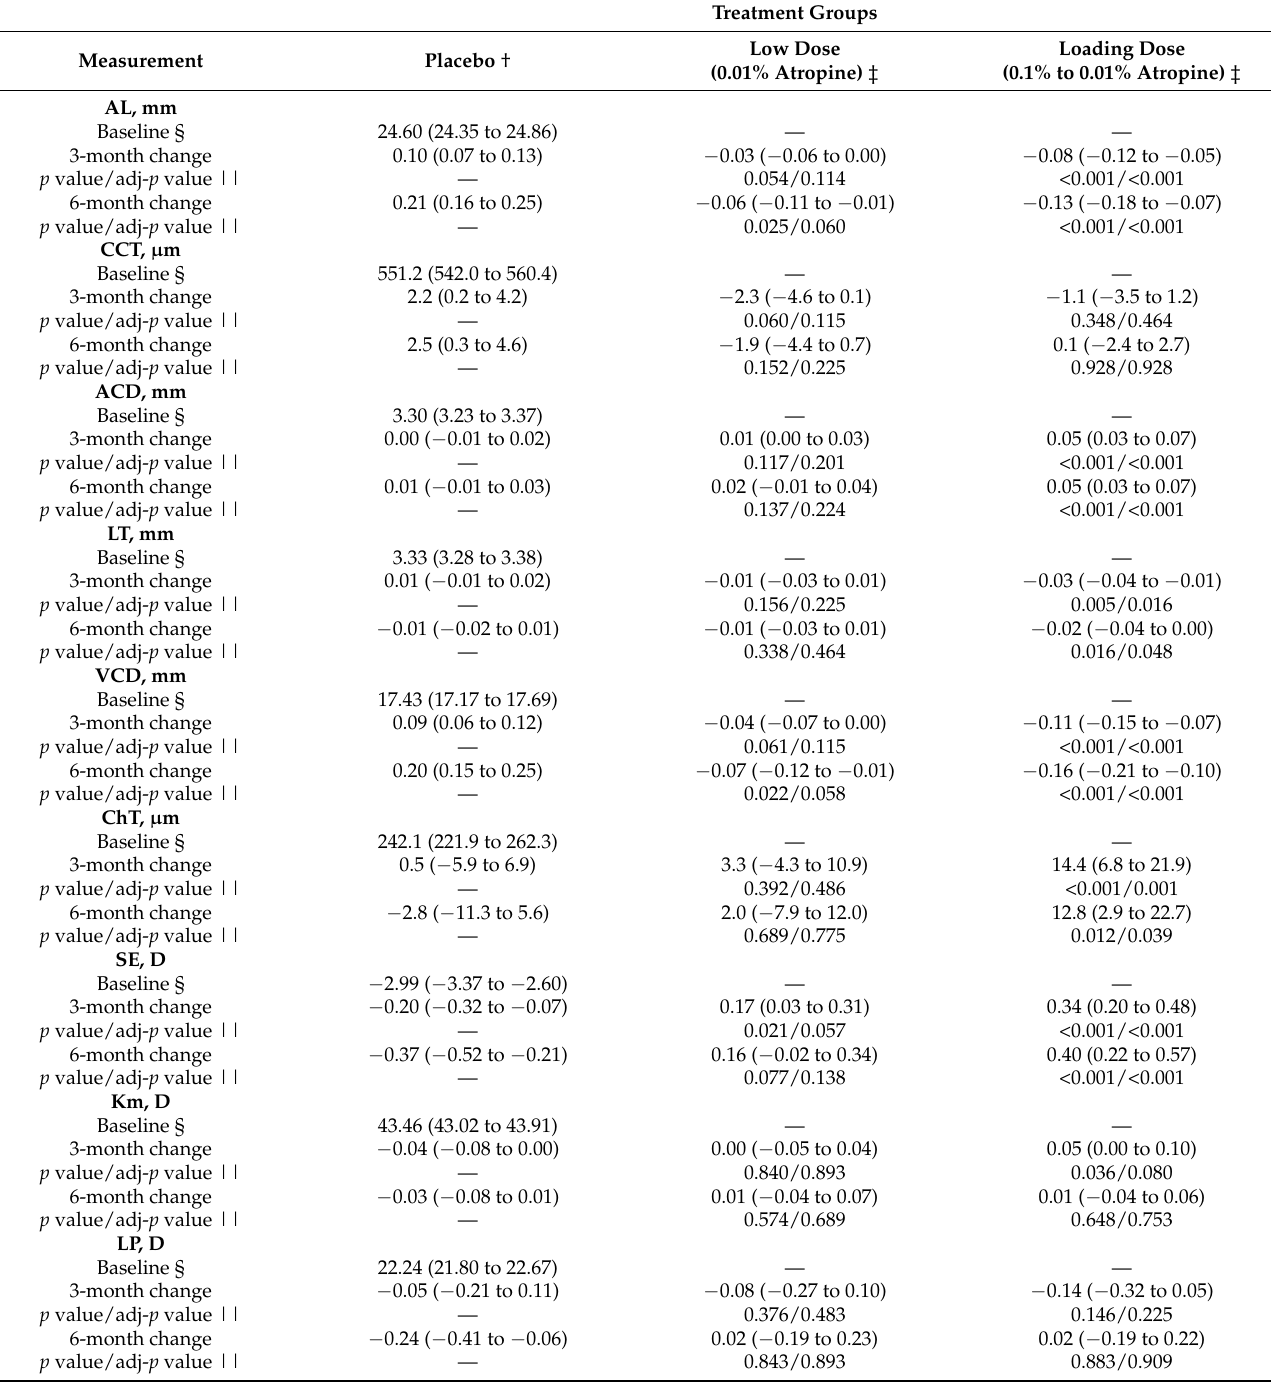
Table 2. Changes in refractive and visual parameters over six months based on constrained linear mixed